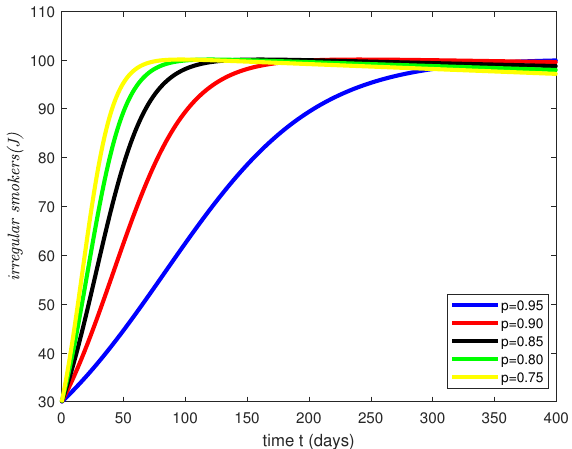
Figure 3. Adaptive nature of the approximated result for the irregular smokers J ( t ) class of the considered model at different arbitrary fractional orders.